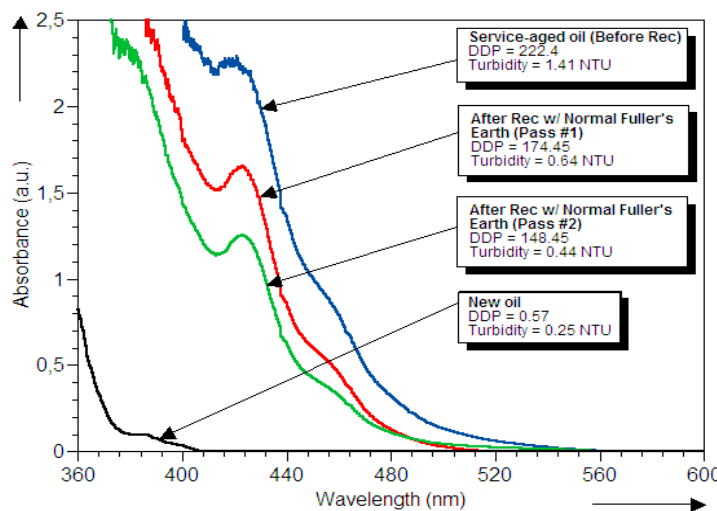
Figure 3. Comparison between new oil and service-aged oil reclaimed with two different types of Fuller’s earth [115]. DDP, dissolved decay product; NTU, nephelometric turbidity unit; Rec, reclamation; Rec w/ Normal Fuller’s Earth, reclaimed with Normal Fuller’s Earth.